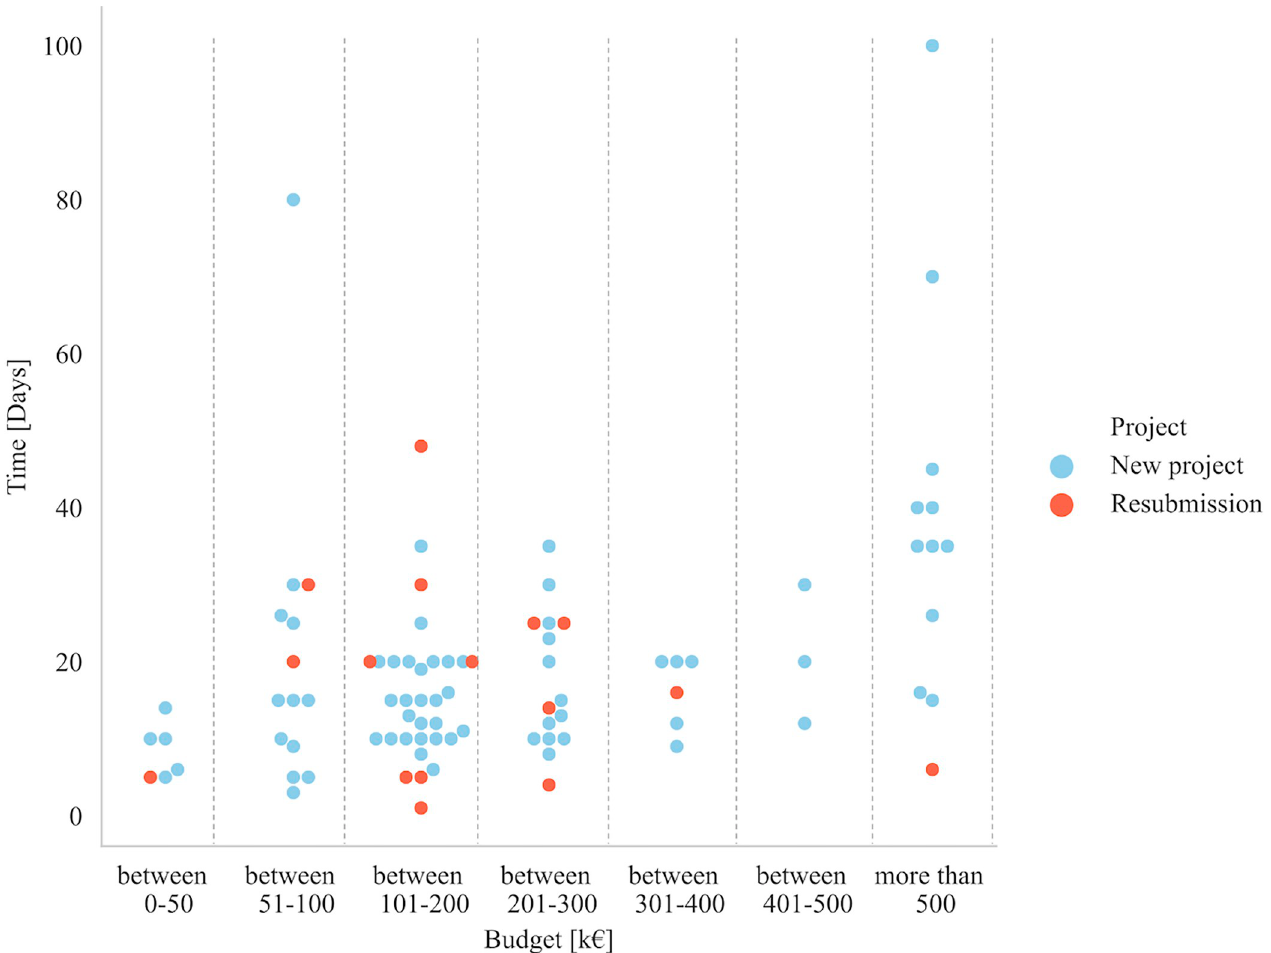
Fig 7. Days (as a continuous variable) spent by the researchers’ organization to prepare either a new (blue) or resubmitted (red) research proposal for the corresponding budget (as a categorical variable).